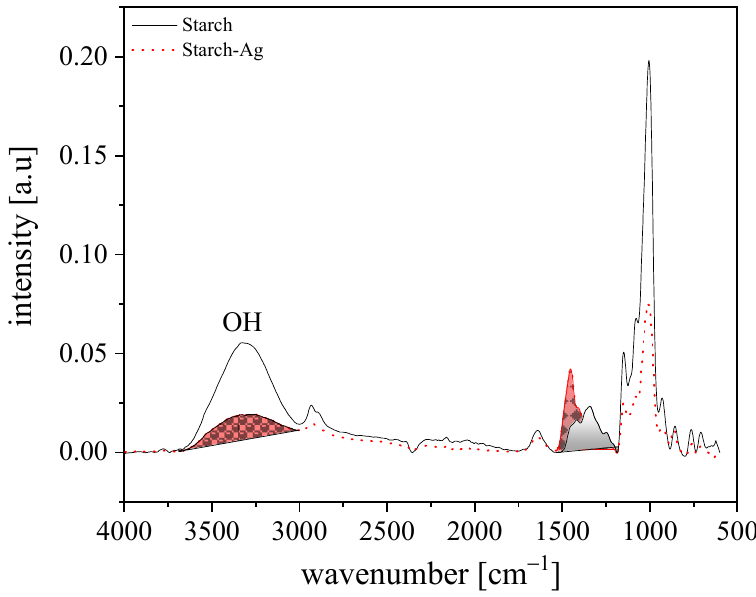
Figure 2. Spectra of starch-Ag nanocomposite in comparison to pure starch as the blank. The FTIR spectrum of starch reveals characteristic absorption bands at ~1080 and ~850 cm − 1 (C–O–C symmetrical stretching), ~1000 and ~928 cm − 1 (COH bending), ~1148 cm − 1 (C–O stretching), ~1246 cm − 1 (deformation vibration of C–O–H), ~1644 cm − 1 (OH